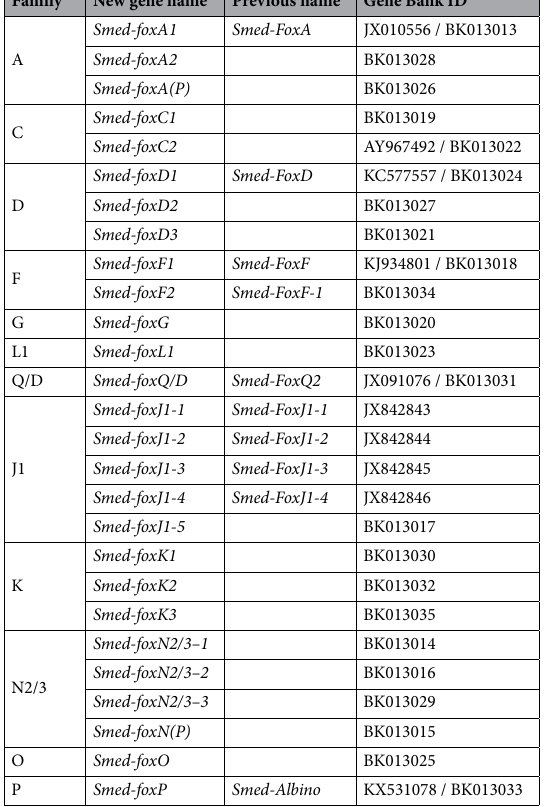
Table 1. Fox genes in Schmidtea mediterranea . New and previous names of Fox genes in Smed are shown, with their corresponding GeneBank